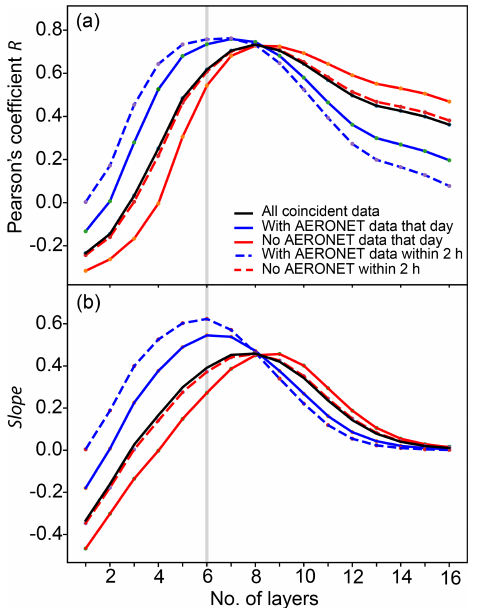
Figure 8. Pearson’s correlation coefficients (a) obtained from hourly surface and MAX-DOAS coincident measurements as a function of the number of layers considered in the VMR averages. The slopes obtained from the linear regressions, performed forcing the intercept to be at zero to the same data sets, are shown in (b) . The layers below layer 6 are very likely inside the mixed boundary layer, while layers above layer 6 might be on the edge or above the bound- ary layer during some hours in the morning (García-Franco et al., 2018). The blue dashed lines only show data when AERONET data are available within 2h of the scan and hence limit the measure- ments to cloud-free conditions. This selection criterion improves the correlation significantly.